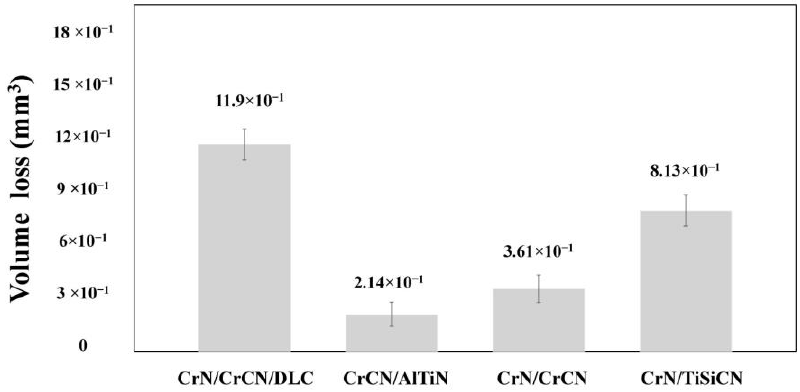
Figure 11. DSRW abrasion test result for different coatings on carbide tips.